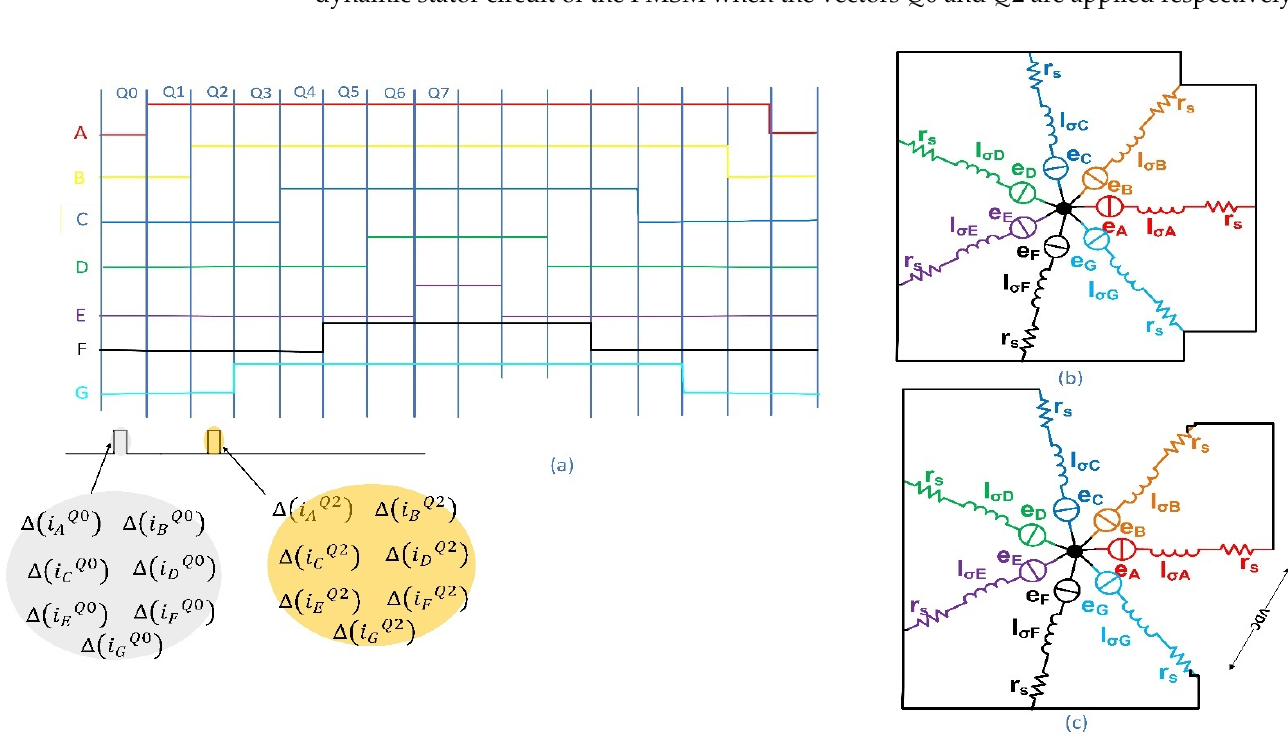
Figure 10. ( a ) Sampling instants when the current response of applying Q2 and Q0 are used to track the saliency, ( b ) dynamic circuit when Q0 is applied, and ( c ) dynamic circuit when Q2 is applied.